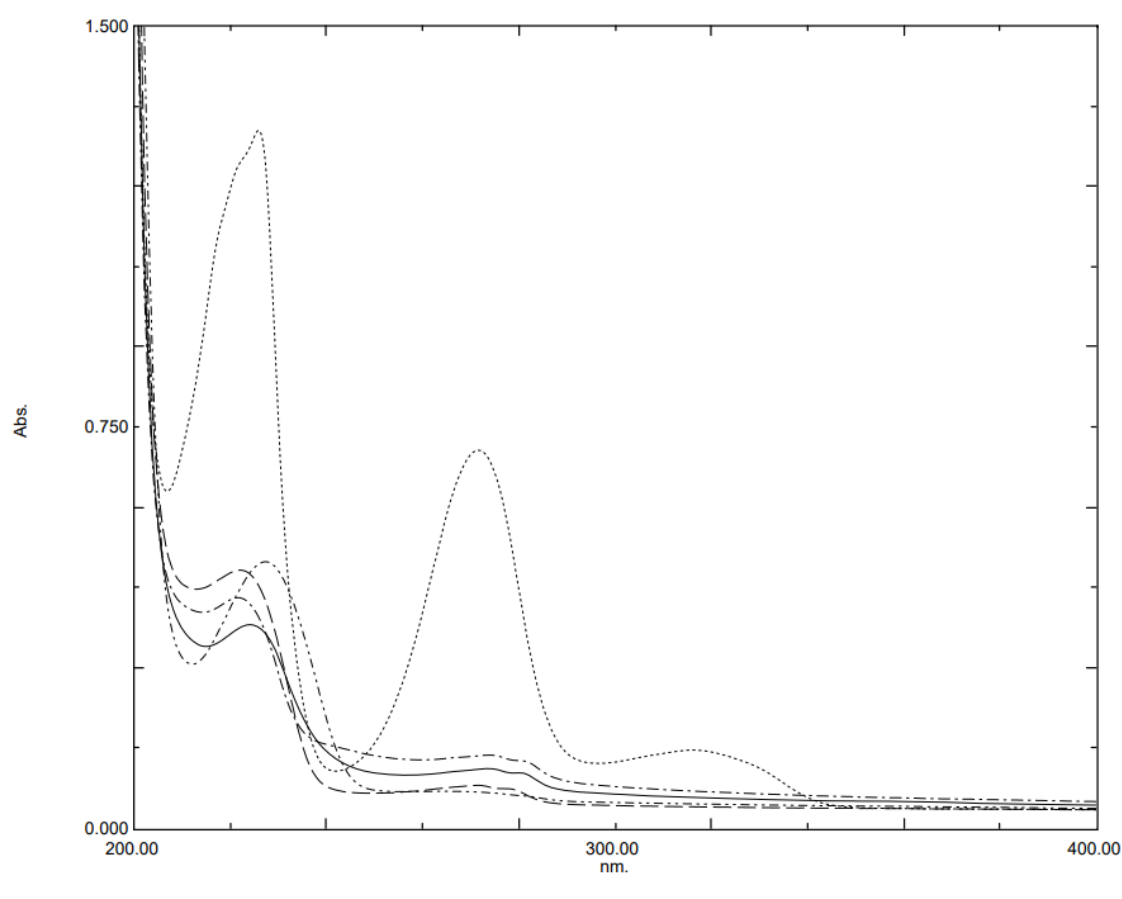
Figure 1. UV absorption spectra of 10 µg mL −1 of AT, ST, MT, BS and HZ.